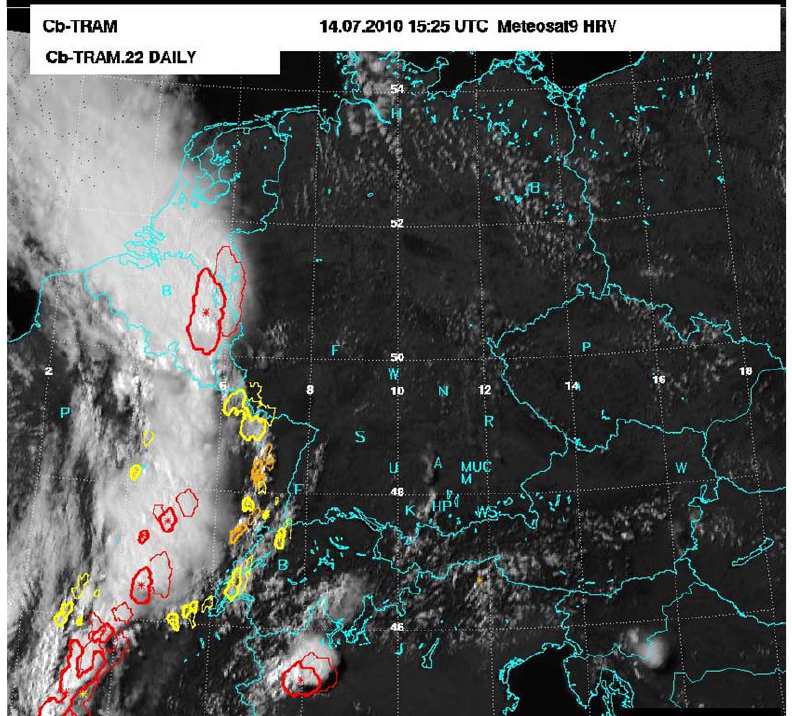
Fig. 1. Meteosat-8 SEVIRI HRV image for 14 July 2010, over Central Europe, 14:25UTC (time of data acquisition). Overlaid is the Cb- TRAM output (thick yellow, orange, red contours) and 30min nowcasts (thin